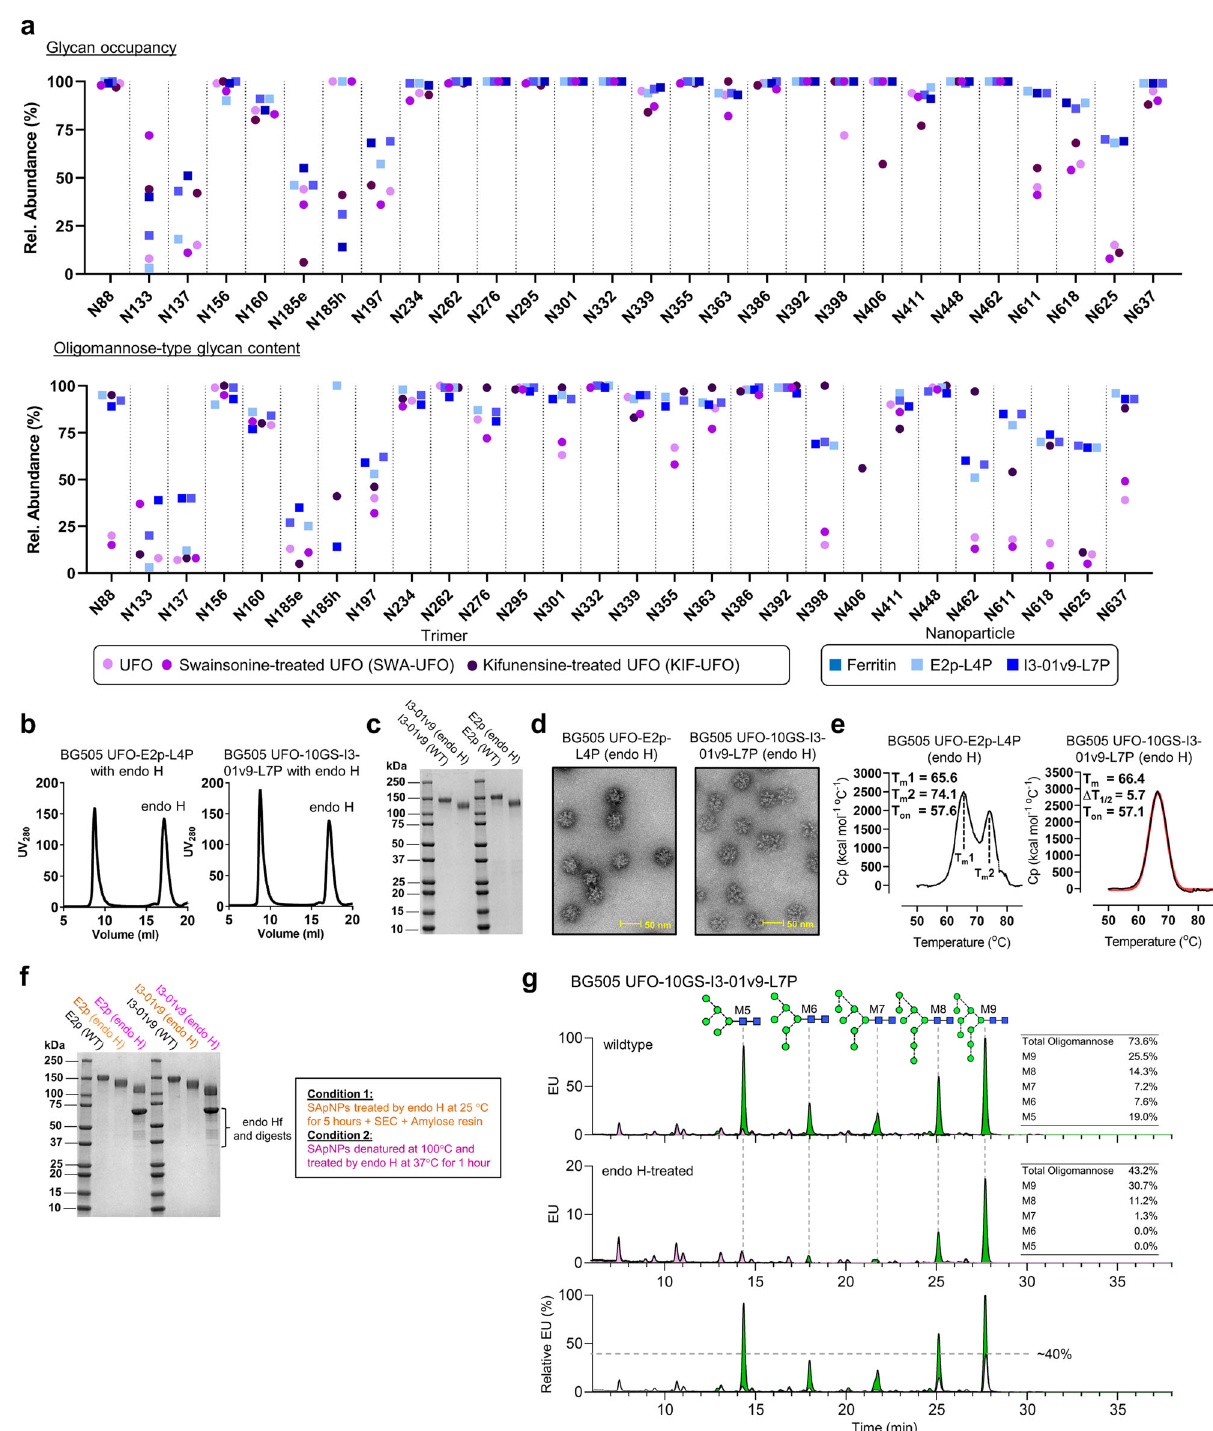
Fig. 3 | Glycan analysis of BG505 Env immunogens with wildtype and modi fi ed glycans. a Comparison of site-speci fi c occupancy and oligomannose-type glycan content for the BG505 UFO trimer (wildtype, swainsonine, and kifunensine) and three SApNPs (wildtype). The plotted data represent the mean of three analytical repeats, with trimers shown as circles and NPs as squares. The oligomannose content was determined by adding all glycan compositions containing HexNAc(2). b SEC pro fi les of BG505 UFO-E2p-L4P and UFO-10GS-I3-01v9-L7P SApNPs upon endoH treatment. c Reducing SDS-PAGE ofBG505 UFO-E2p-L4Pand UFO-10GS-I3- 01v9-L7P SApNPs before and after glycan trimming by endo H. d EM images of glycan-trimmed BG505 UFO-E2p-L4P and UFO-10GS-I3-01v9-L7P SApNPs. e Thermostability of glycan-trimmed BG505 UFO-E2p-L4P and UFO-10GS-I3-01v9- L7P SApNPs, with T m , Δ T 1/2 , and T on measured by DSC. f Reducing SDS-PAGE of